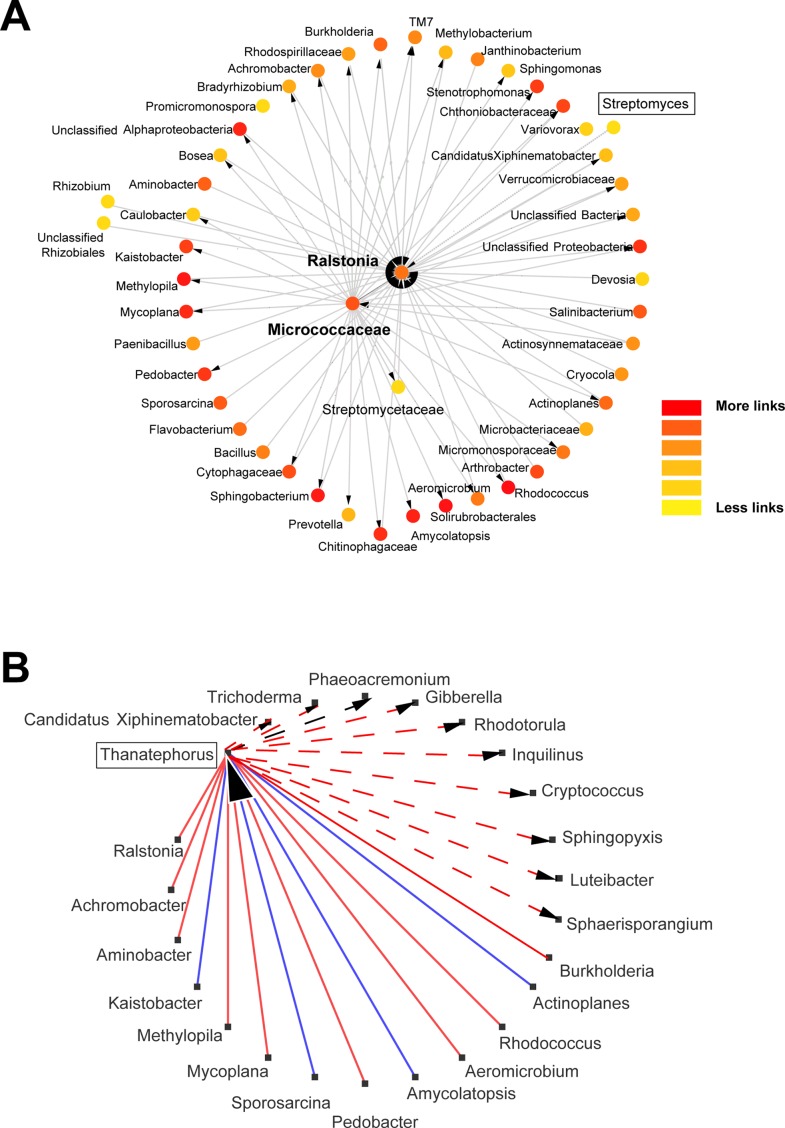
Network analysis for bacterial and fungal groups found in the wheat roots. Detailed networks were selected for Streptomyces and its neighbors (A), and Thanatephorus connections (B) to visualize which taxonomic groups are directly affected by these taxa; negative and positive interactions are marked red and blue, respectively. Network analyses were conducted using molecular ecological network analysis pipeline (MENA; http://ieg4.rccc.ou.edu/MENA/) to generate the networks with a cutoff of 0.9 and Cytoscape environment to visualize and redesign the networks. Yellow to red color in network A means more links within the network.